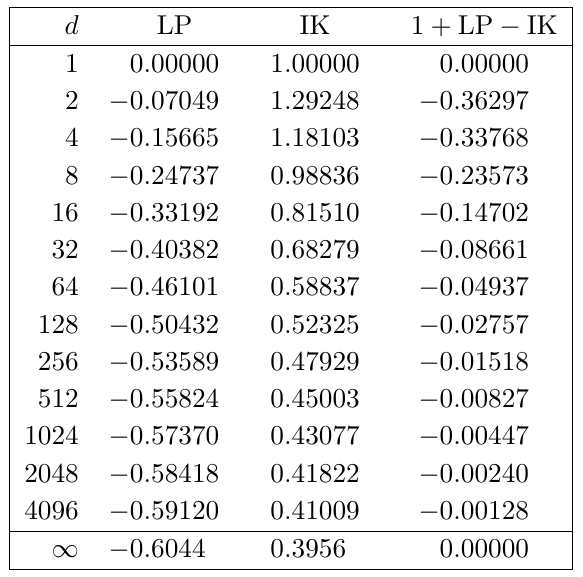
Table 3 . Numerical comparison of the linear programming bound for the sphere packing density in R d (denoted LP) with the implied kissing number (denoted IK), both in the form log